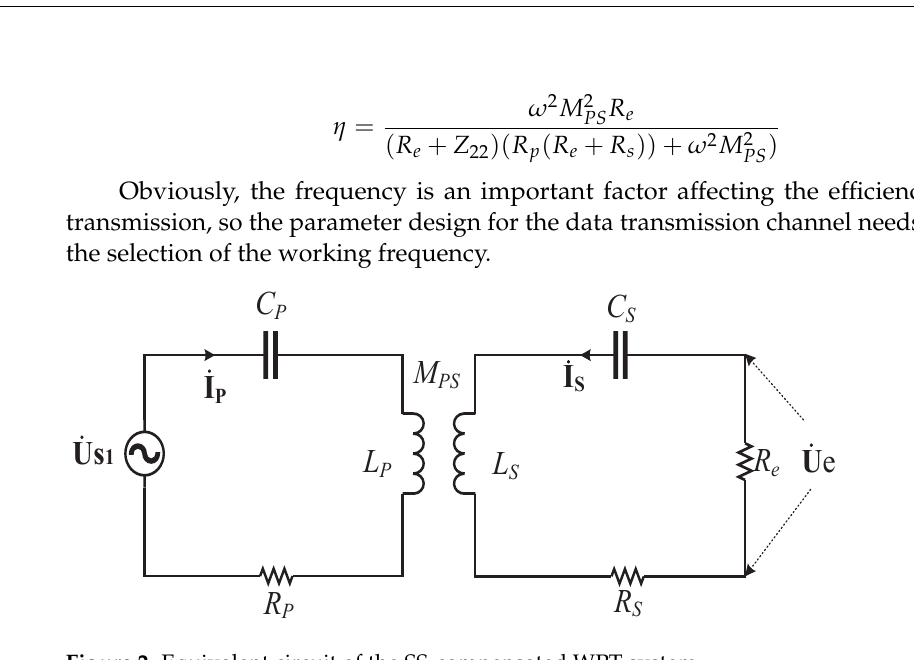
Figure 2. Equivalent circuit of the SS-compensated WPT